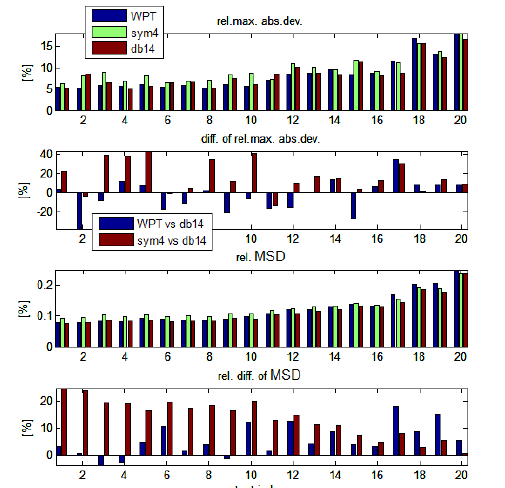
Figure 17. From top to bottom: relative maxim absolute deviations; relative percentage di ff erences (with db14 as reference) for relative maxim absolute deviations ; mean square relative deviations; rela- tive percentage di ff erences (with db14 as reference) for mean square relative deviations. 3-rd